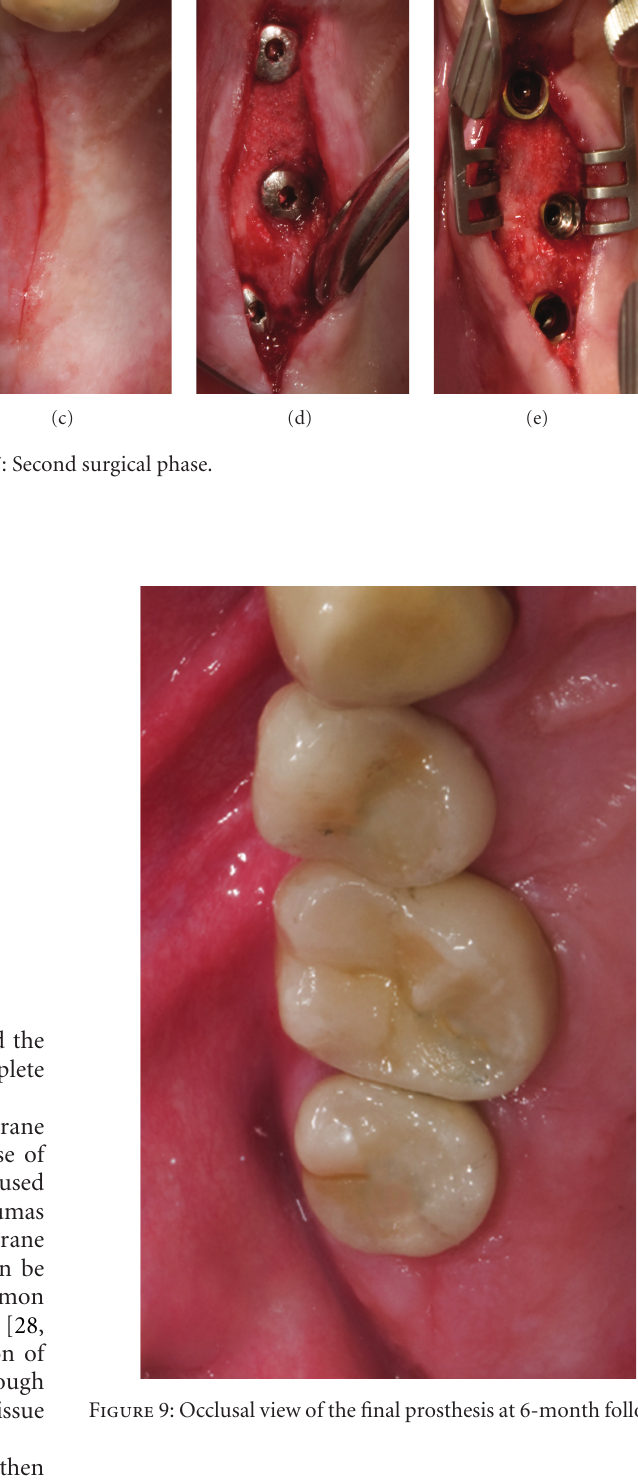
Figure 9: Occlusal view of the final prosthesis at 6-month